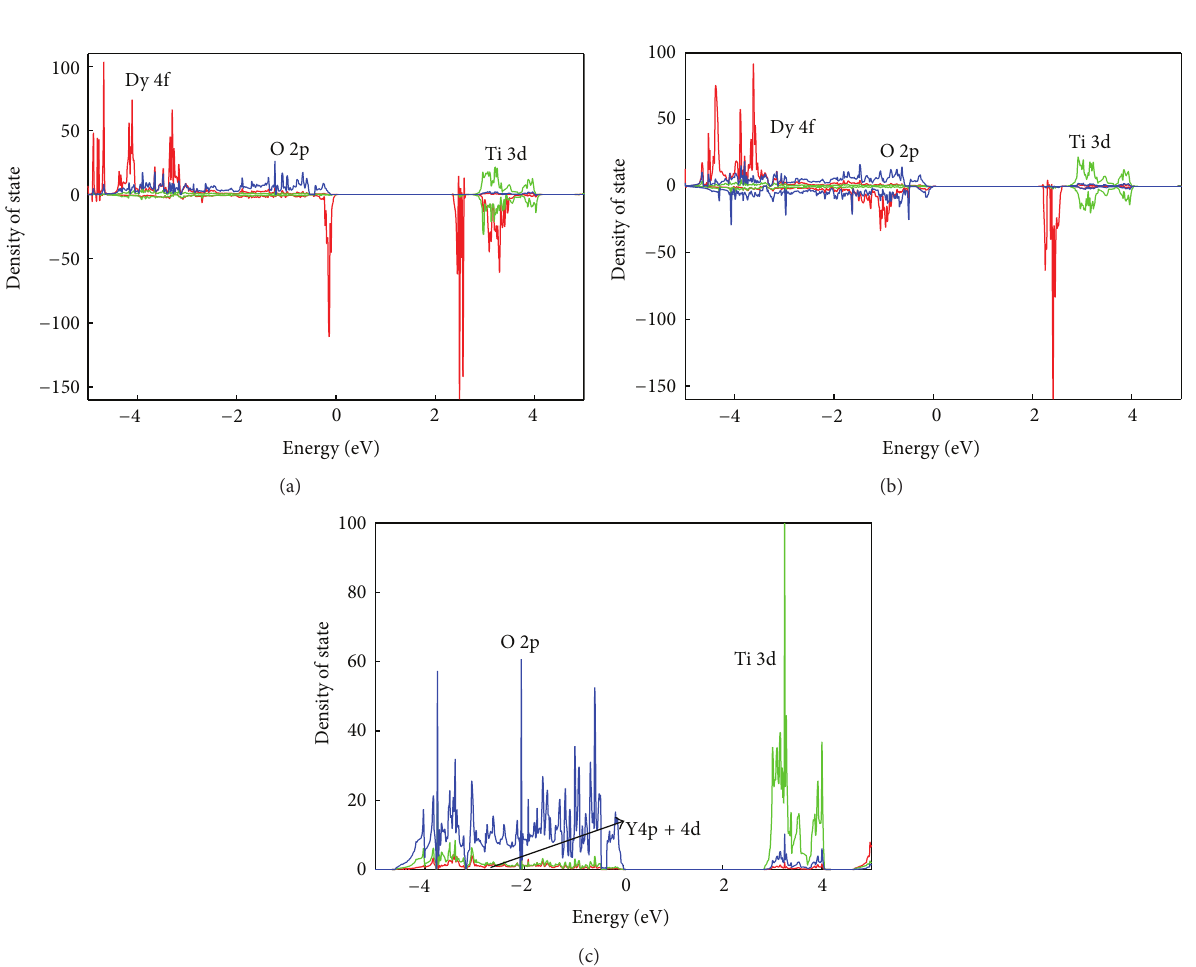
Figure 7: Partial DOS distributions of (a) Dy 2 Ti 2 O 7 ; (b) Ho 2 Ti 2 O 7 ; and (c) Y 2 Ti 2 O 7